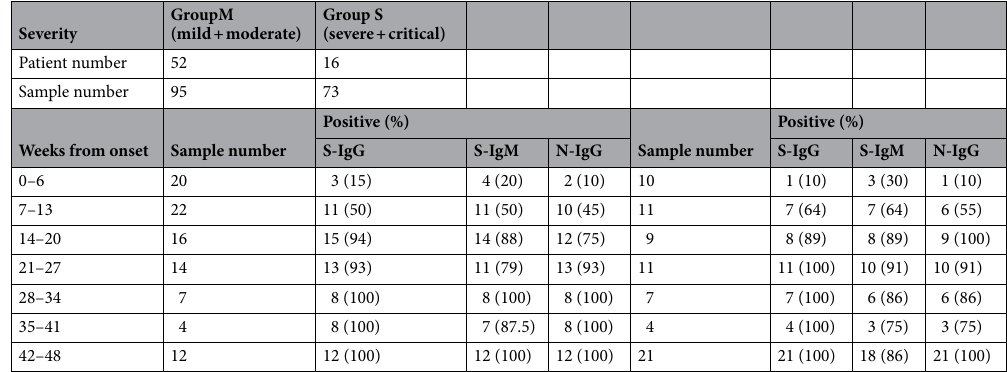
Table 2. Positivity of SARS-CoV-2 antibody